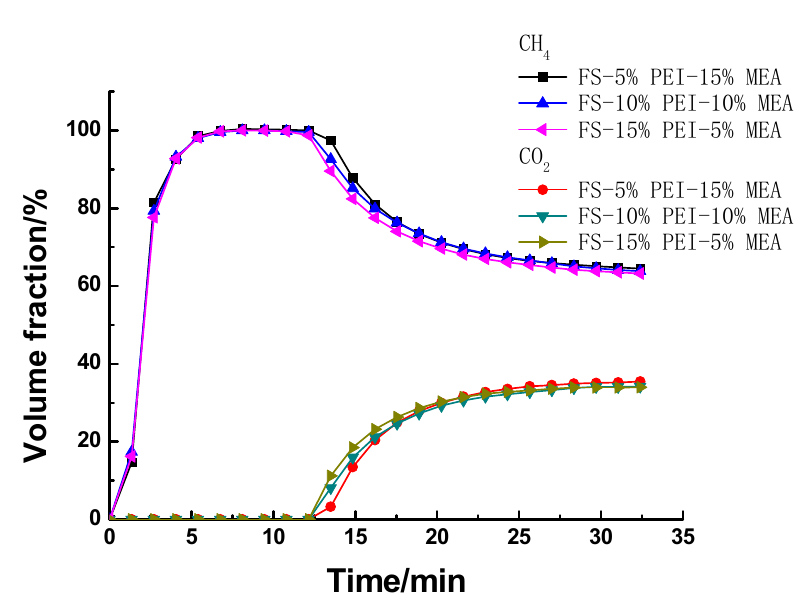
Figure 8. The breakthrough curves over FS functionalized by different ratios of polyethyleneimine (PEI) to ethanolamine (MEA).